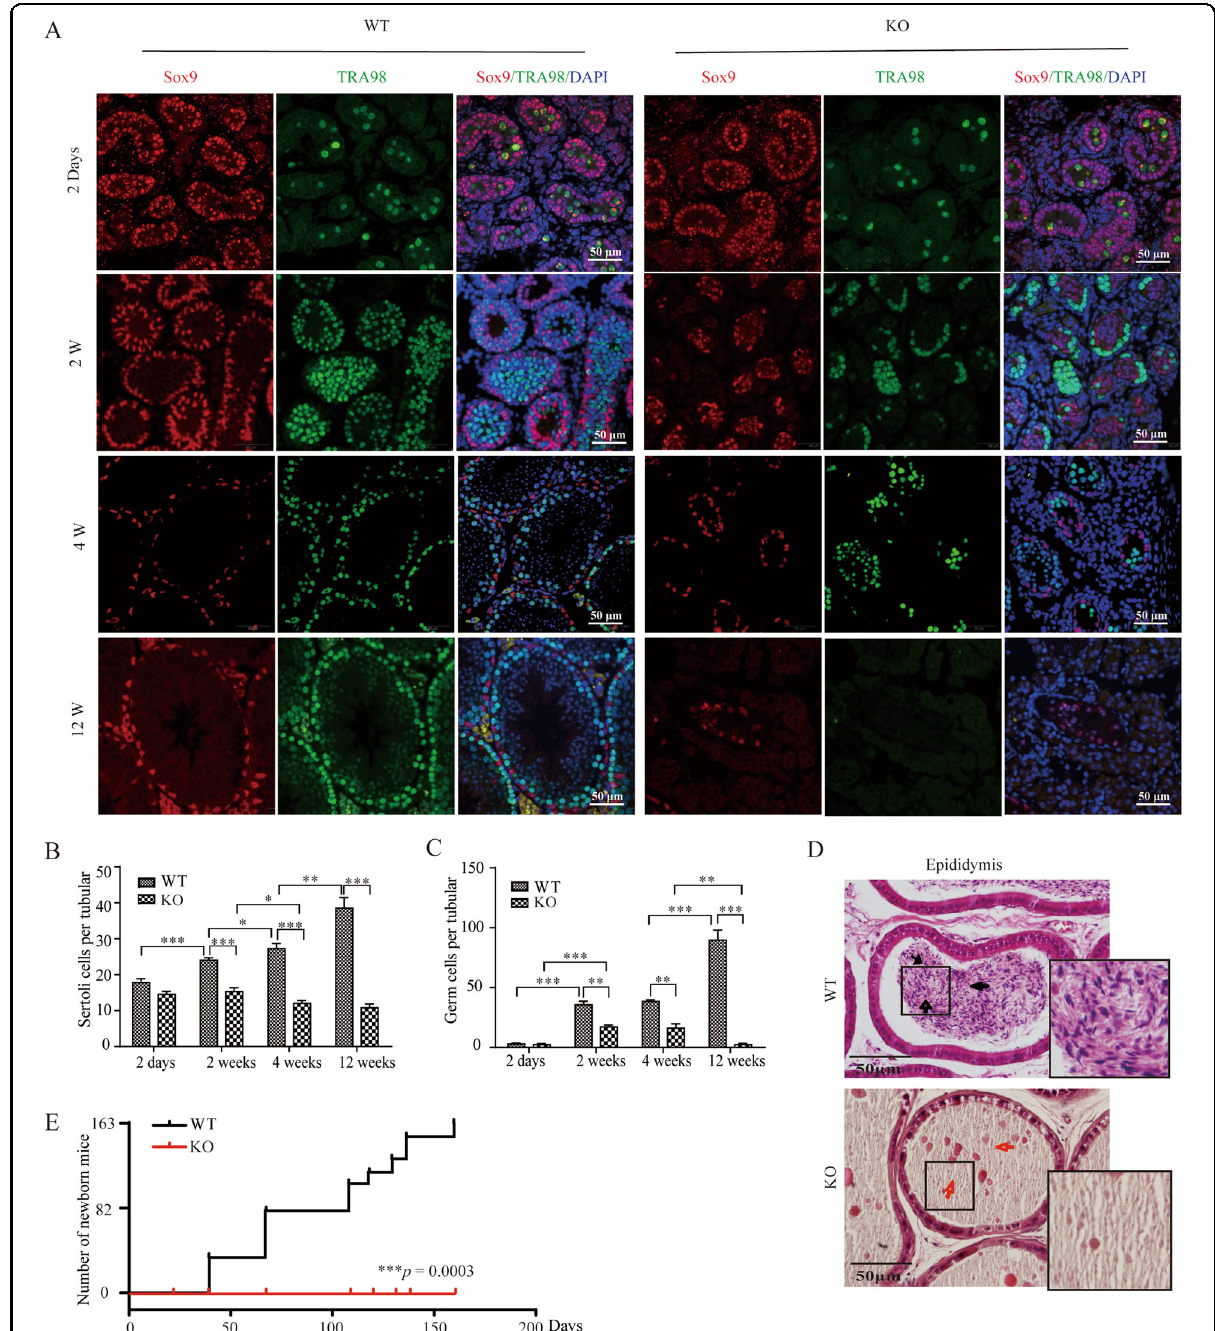
Fig. 2 Male mice with Kindlin-2 speci fi c knockout in Sertoli cells are infertile. A Immuno fl uorescence staining for Sox9 (red) or TRA98 (green) in WT and KO testes samples at 2 day, 2-, 4- and 12-W old. The nuclei were stained blue with DAPI. KO mice showed a phenotype corresponding to an age- dependent loss of GCs in seminiferous tubules. By 12W, KO seminiferous tubules are fi lled only with Sox9 positive SCs, whereas completely loss of GCs. Scale bar, 50 μ m. B Quantitation of Sox9 positive SCs per tubule in testes of the WT and KO mice at indicated age point, 6 tubules were counted per section. The data were expressed as the mean ± S.D. Statistical analyses were performed using Student ’ s t -test at indicated time point. The variance was similar between the groups. * p <0.05, ** p <0.01, *** p <0.001. C Quantitation of TRA98 positive GCs per tubule in testes of the WT and KO mice at indicated age point, 6 tubules were counted per section. The data were expressed as the mean ± S.D. Statistical analyses were performed using Student ’ s t -test at indicated time point. The variance was similar between the groups. * p <0.05, ** p <0.01, *** p <0.001. D HE staining of epididymis of 8W WT and KO mice. The epididymis of WT mice was fi lled with mature sperms (black arrows). However, no spermatocytes or mature sperms were detectable in epididymis of KO mice (red arrow). Scale bar, 50 μ m. E Fertility test that KO males crossed to WT females was detected. Reproductive ability of the KO line was tracked over 160 days breeding period. Fertility test were showed by percent of pregnant females. n = 6 for KO or WT males. *** p =